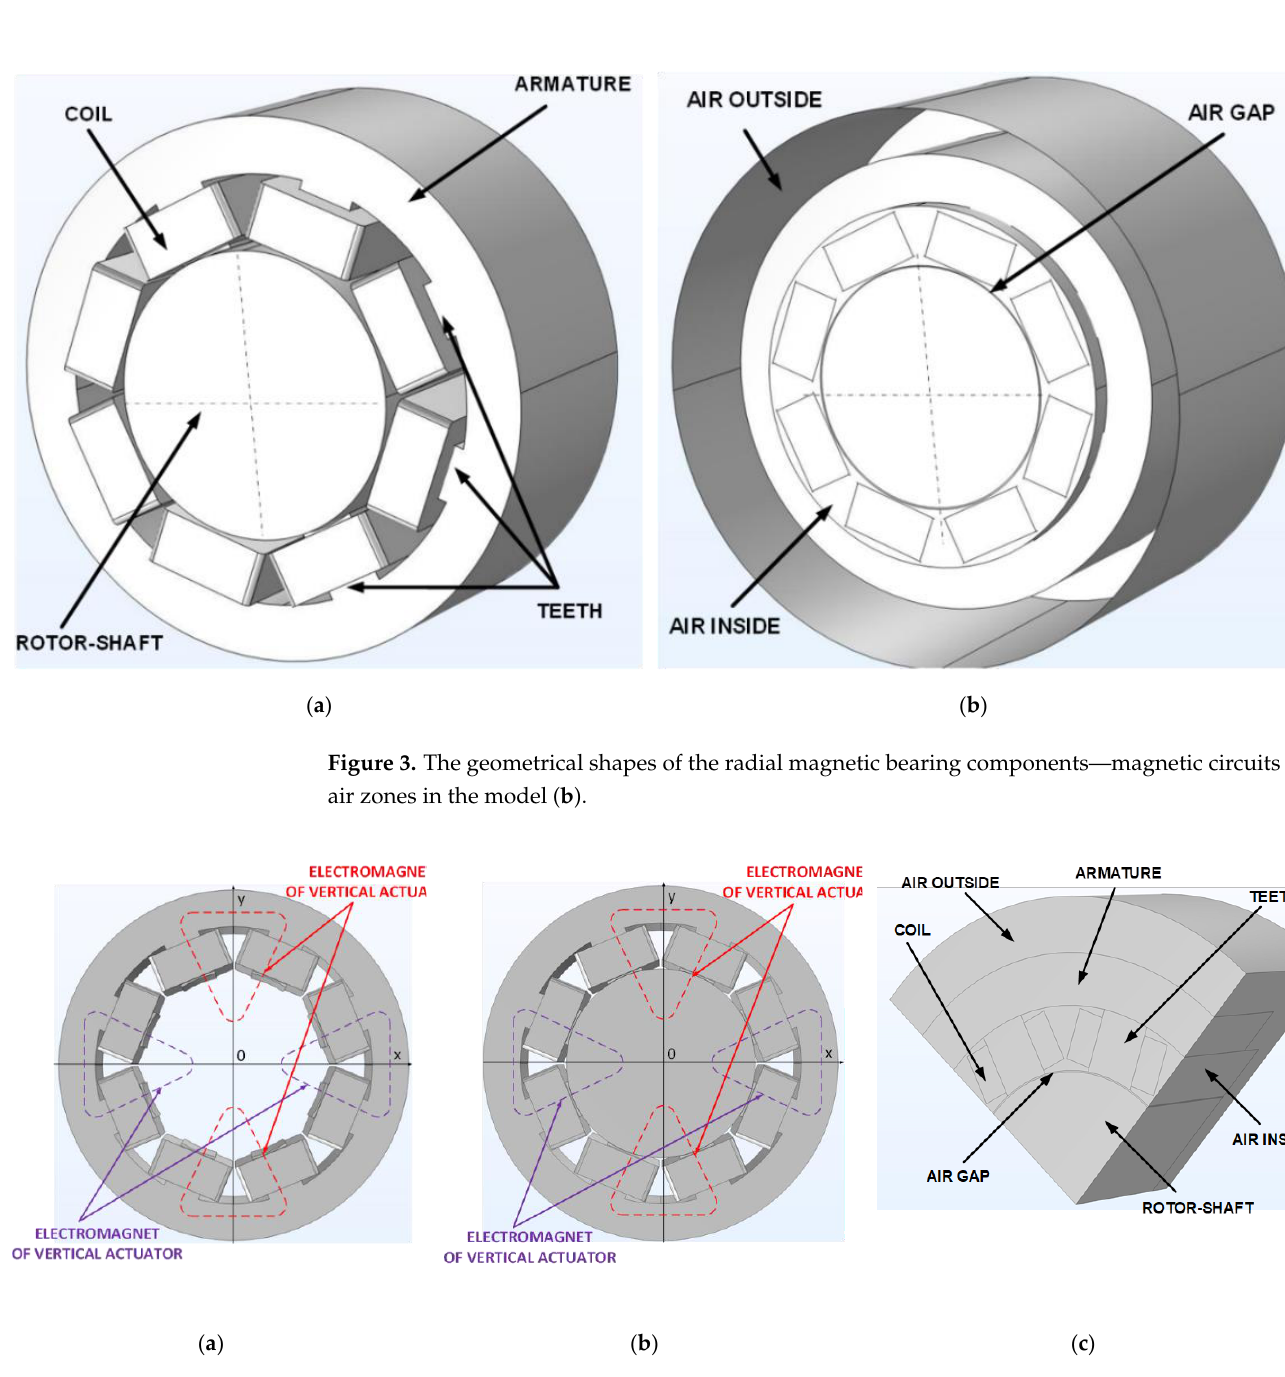
Figure 4. Electromagnetic actuators of the radial electromagnetic bearing – the armature of the actuator ( a ) and the rotor as an element of the actuator ( b ); reduced model of the radial electromagnetic bearing ( c